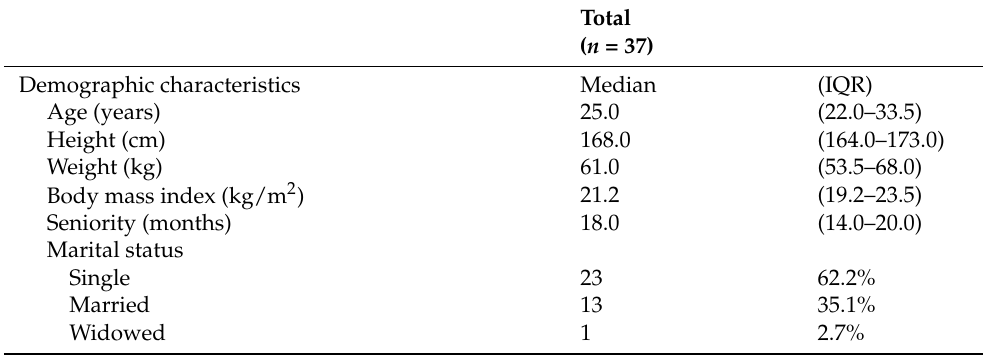
Table 1. Baseline characteristics of the